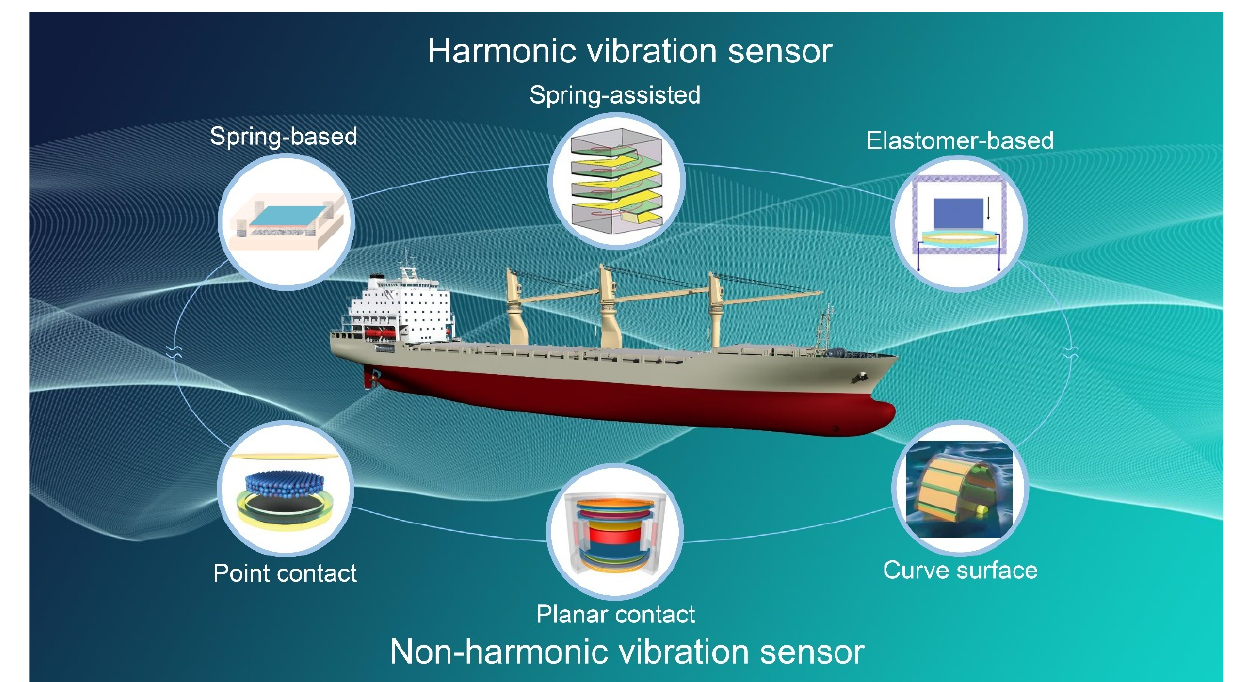
Figure 1. A marine self-powered vibration sensor based on a triboelectric nanogenerator.